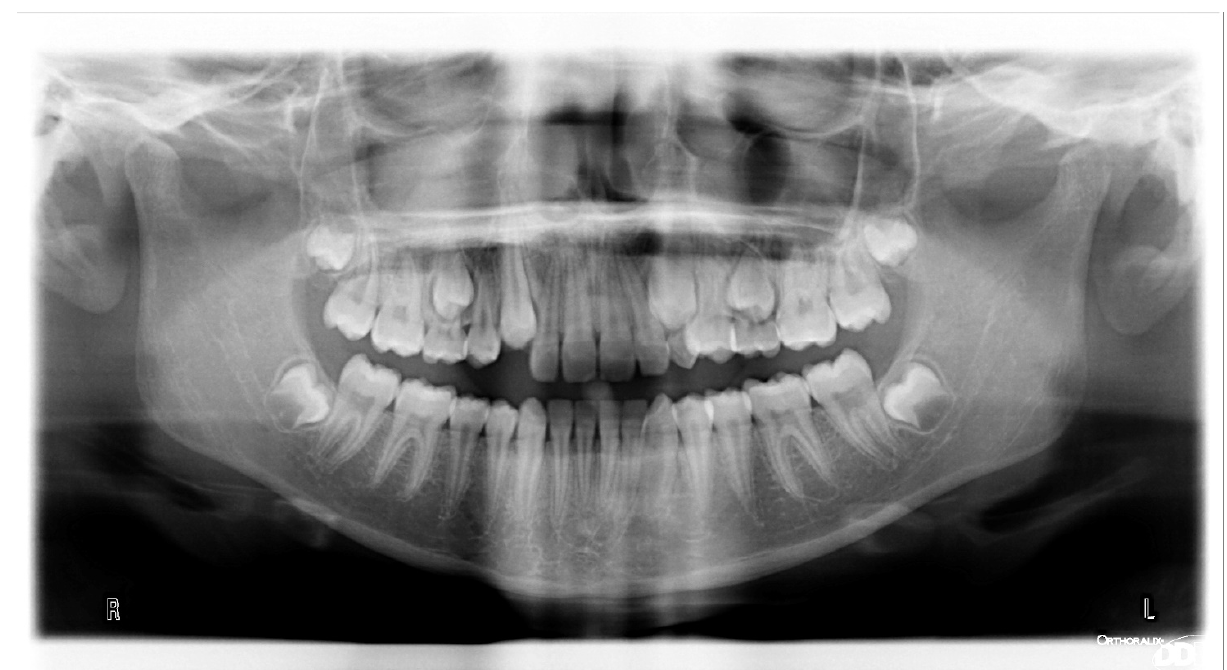
Figure 5. Radiographs of the subject at the screening. Orthopantomography X-ray before treatment (10-year-old).